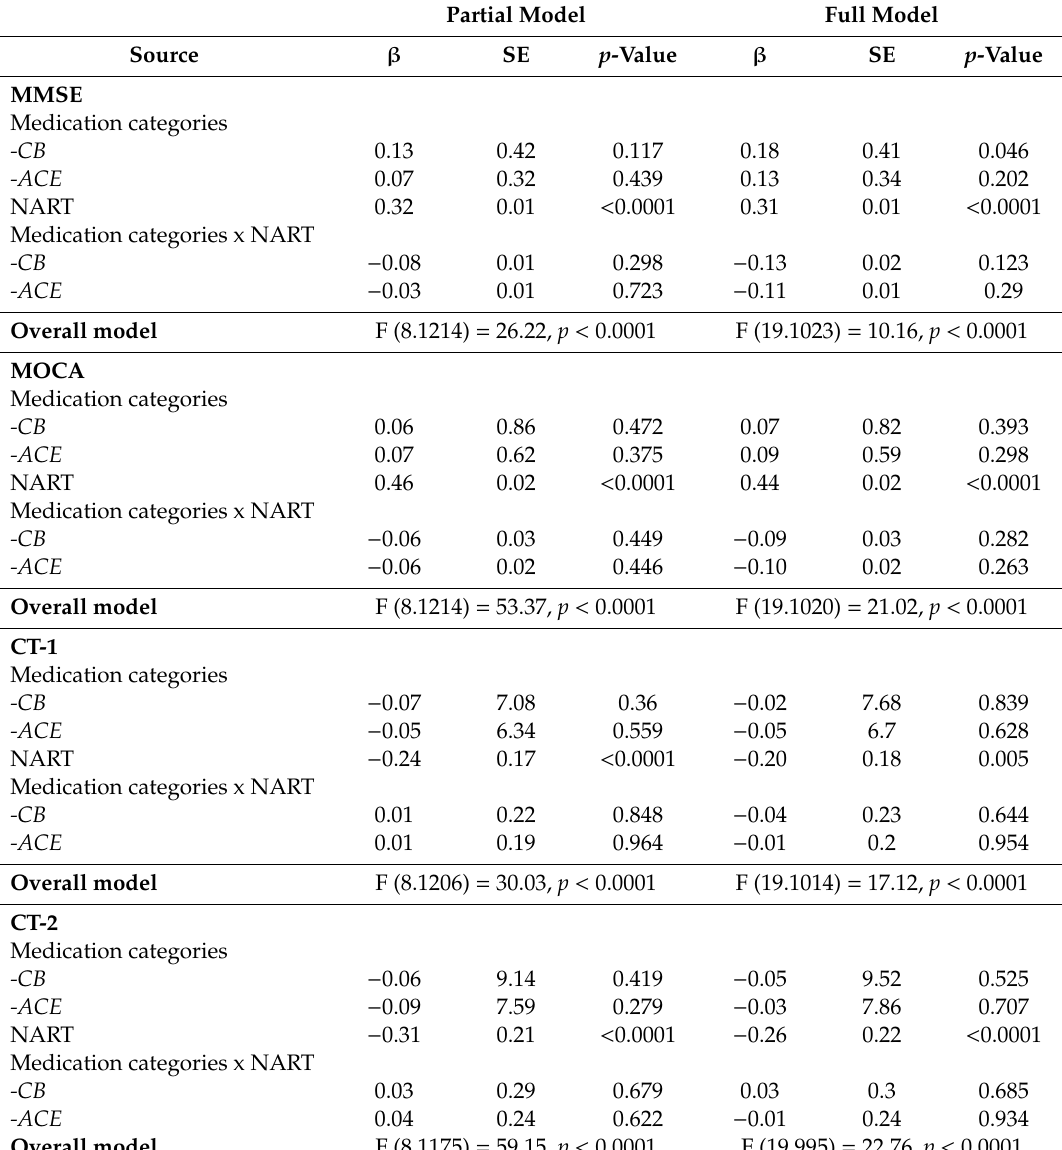
Table 7. Multivariate regression results of the e ff ects of medication categories on di ff erent cognitive